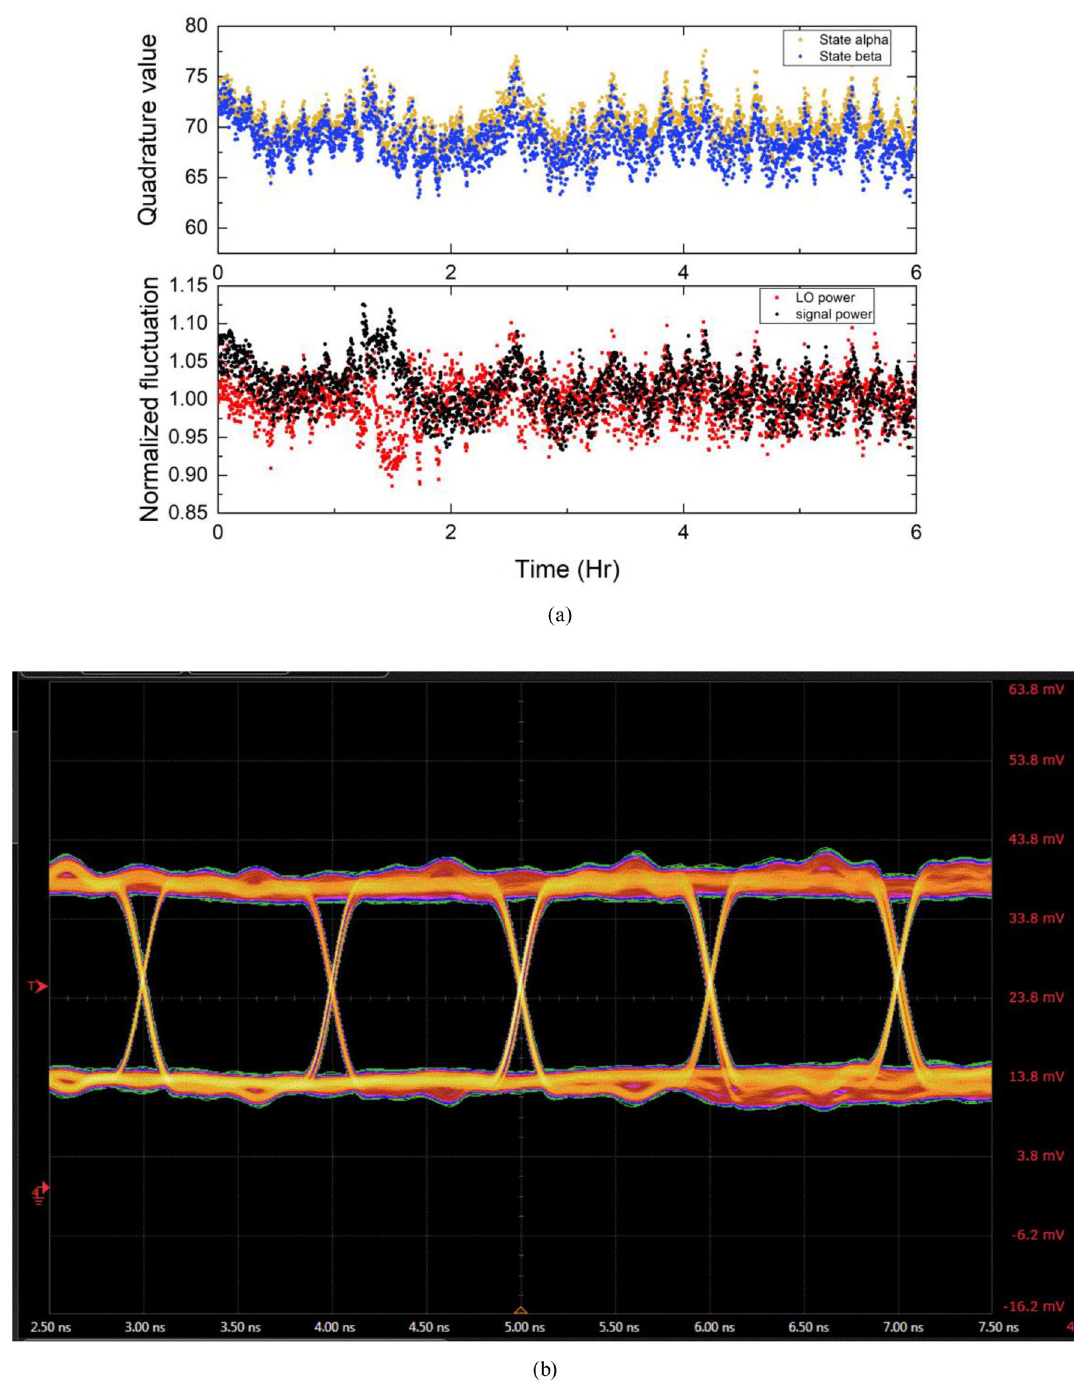
Figure 10. ( a ) Example of received quantum modulated signal and the recorded LO and signal fluctuation over 6 h. ( b ) The received eye diagram of classical OOK